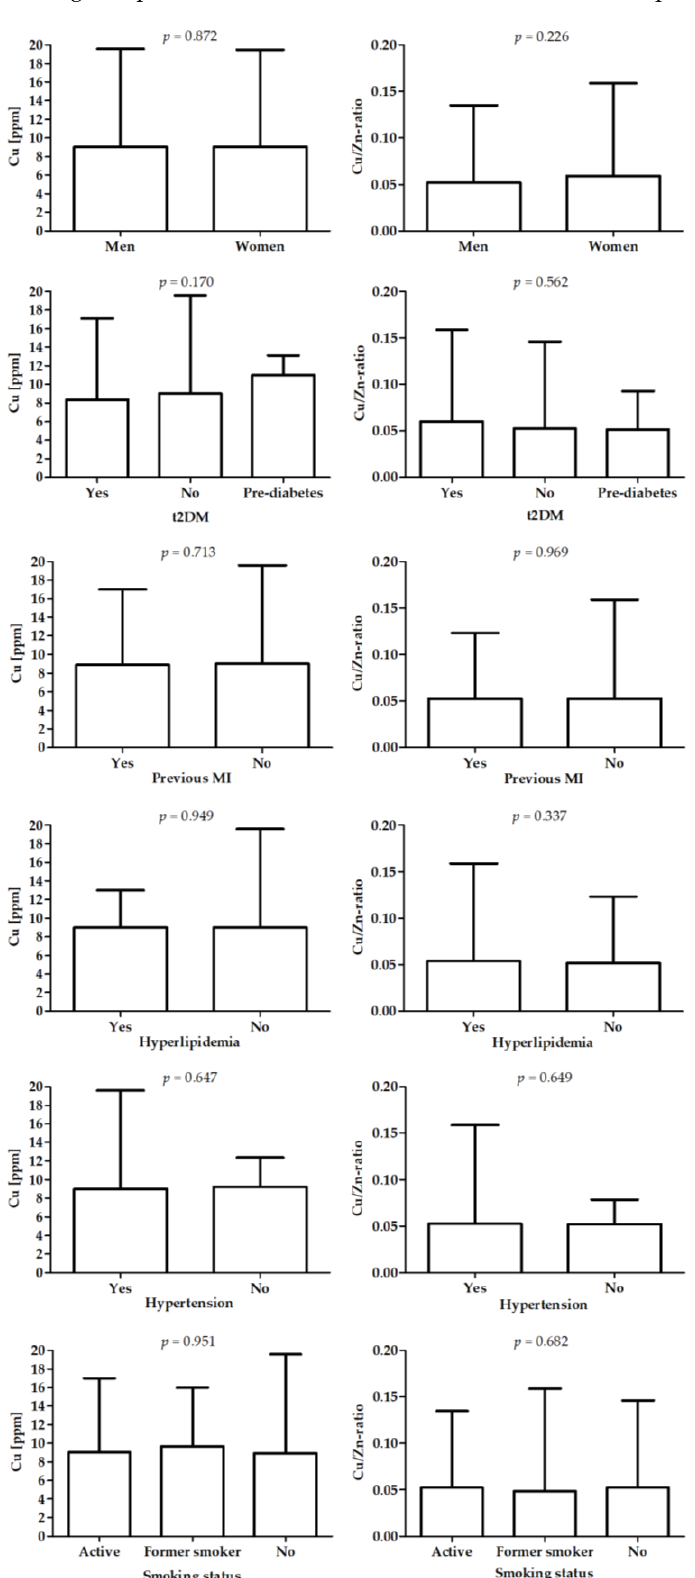
Figure 3. Figure 3. Differences in Cu (left panel) and Cu/Zn-ratio (right panel) between patients with different diagnoses.